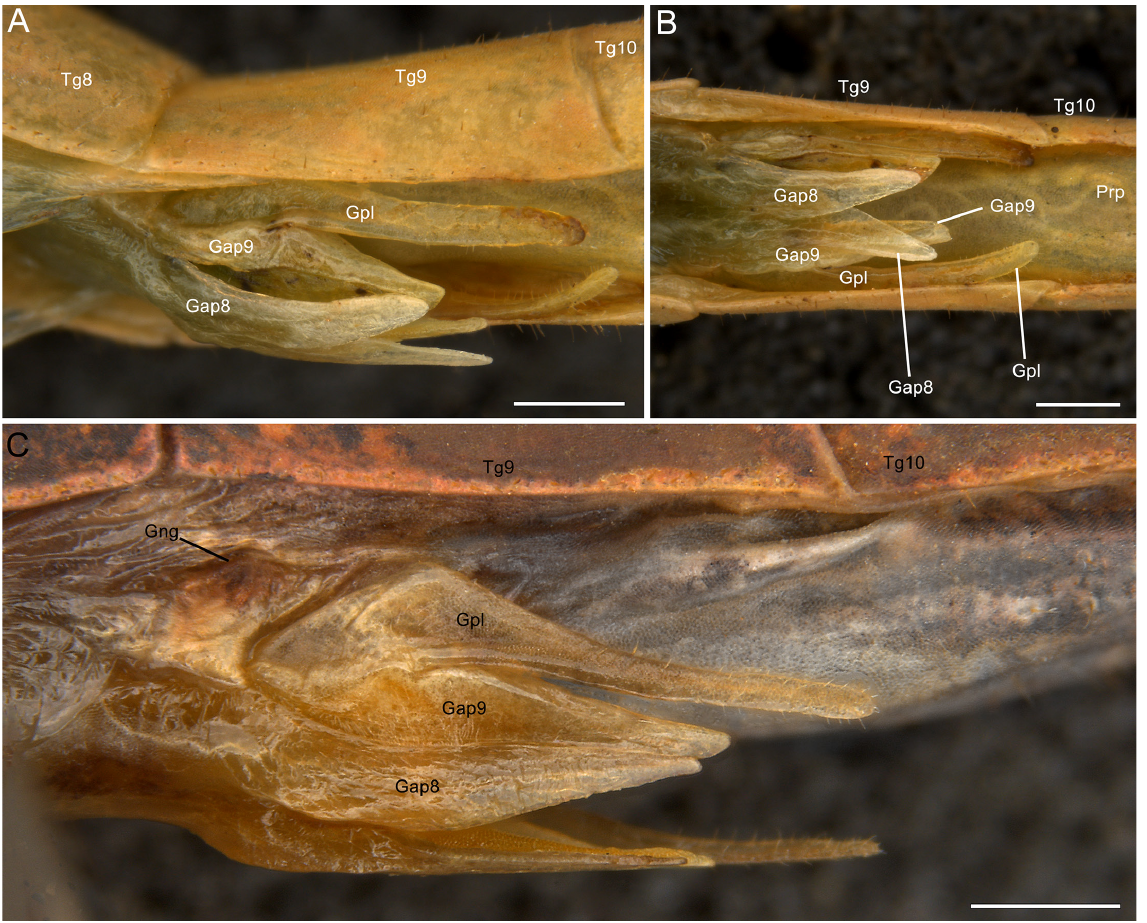
Fig. 8. External genitalia of Arumatia dubia (Caudell, 1904) gen. et comb. nov. A–B . Adult ♀ (MZUSP V0534) from Chapadão do Sul, Mato Grosso do Sul, Brazil, lateral (A) and ventral (B) views. C . Adult ♀ (MZUSP V0547) from Araguari, Minas Gerais, Brazil, lateral view. Abbreviations: Gap = gonapophysis; Gng = gonangulum; Gpl = gonoplac; Prp = paraproct; Tg = tergum. Scale bars: 0.5